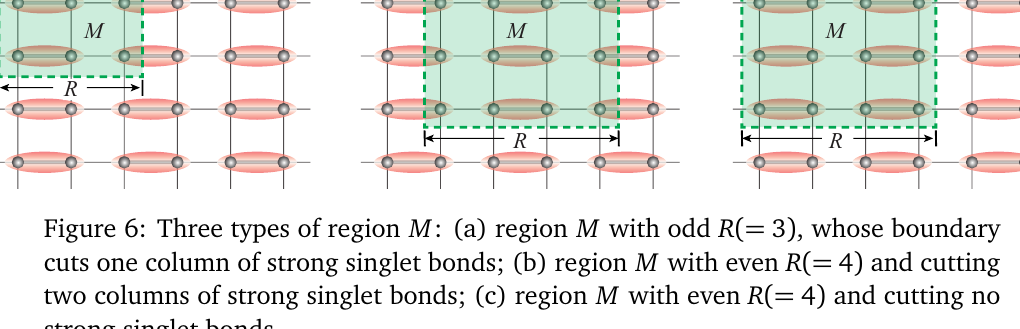
Figure 6: Three types of region M : (a) region M with odd R (= 3 ) , whose boundary cuts one column of strong singlet bonds; (b) region M with even R (= 4 ) and cutting two columns of strong singlet bonds; (c) region M with even R (= 4 ) and cutting no strong singlet